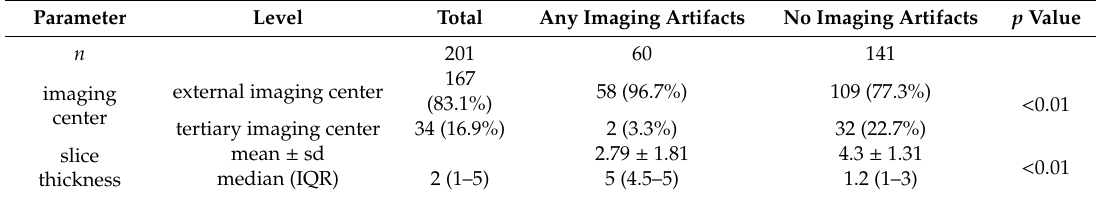
Table 2. Summary of imaging artifacts, CT slice thickness, and imaging center. IQR, inter-quartile range. Parameter Level Total Any Imaging Artifacts imaging